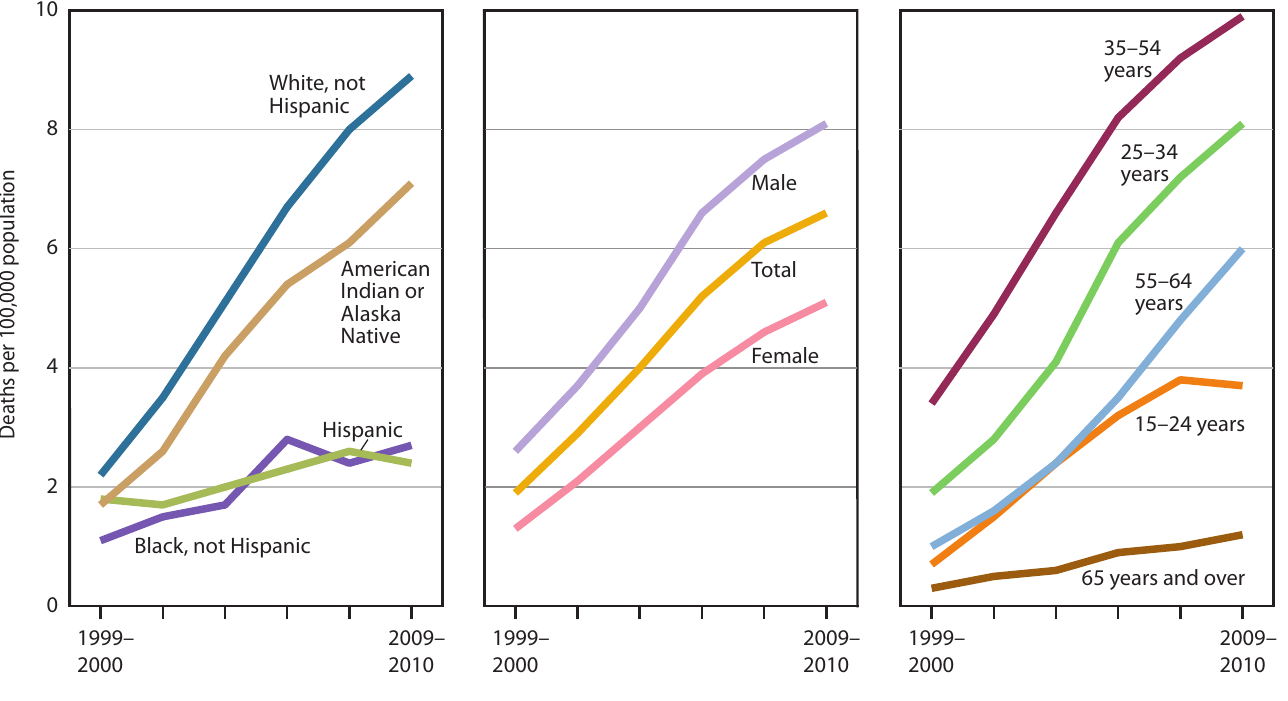
Figure 28. Drug poisoning deaths involving opioid analgesics among persons aged 15 and over, by race and